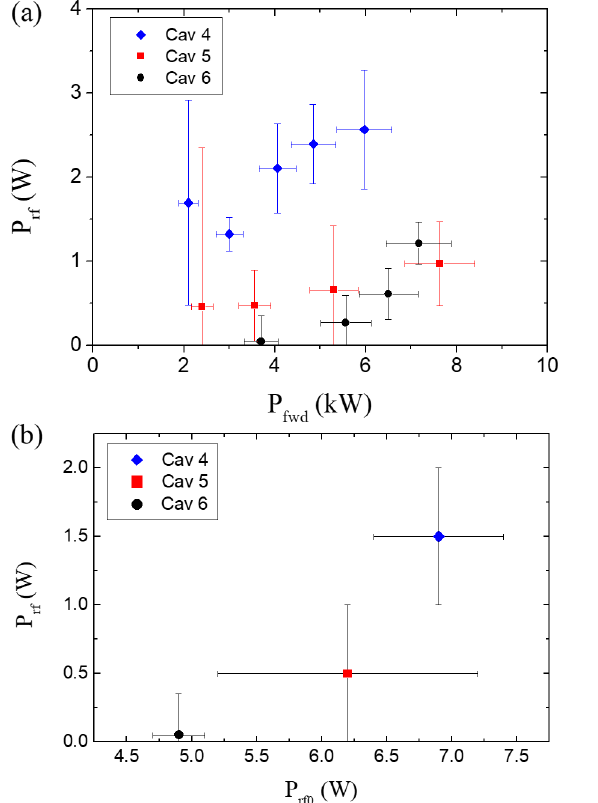
FIG. 13. The rf heat load at 2.07 K in the case of fully detuned cavities, as a function of the forward power measured in C20 CM ¼ 7 MV = m FEL-04 (a) and rf heat load of fully detuned cavities for P f ∼ acc 2 . 5 kW as a function of the rf heat load with the cavities on crest ( ϕ ¼ 0 °) at 7 MV = m